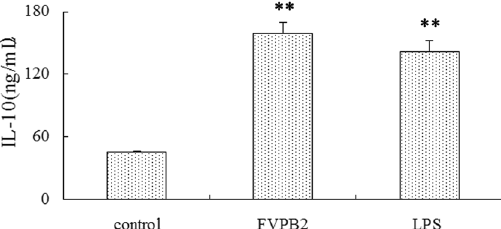
Figure 7. Effect of FVPB2 on IL-10 released by purified B cells was investigated by ELISA assay. The B cells were incubated with 200 μ g/mL FVPB2, 10 μ g/mL LPS or PBS (as control) for 4 days. Each bar represents the mean ± SD of three replications. Values with asterisks are significantly different ( ** P < 0.01 VS